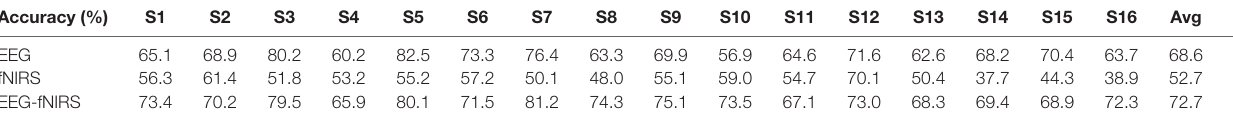
TABLE 1 | The classification results for three intentions of each participant based on the five features of complex brain networks calculated from electroencephalography (EEG), functional near-infrared spectroscopy (fNIRS) and EEG-fNIRS signals. Accuracy (%)